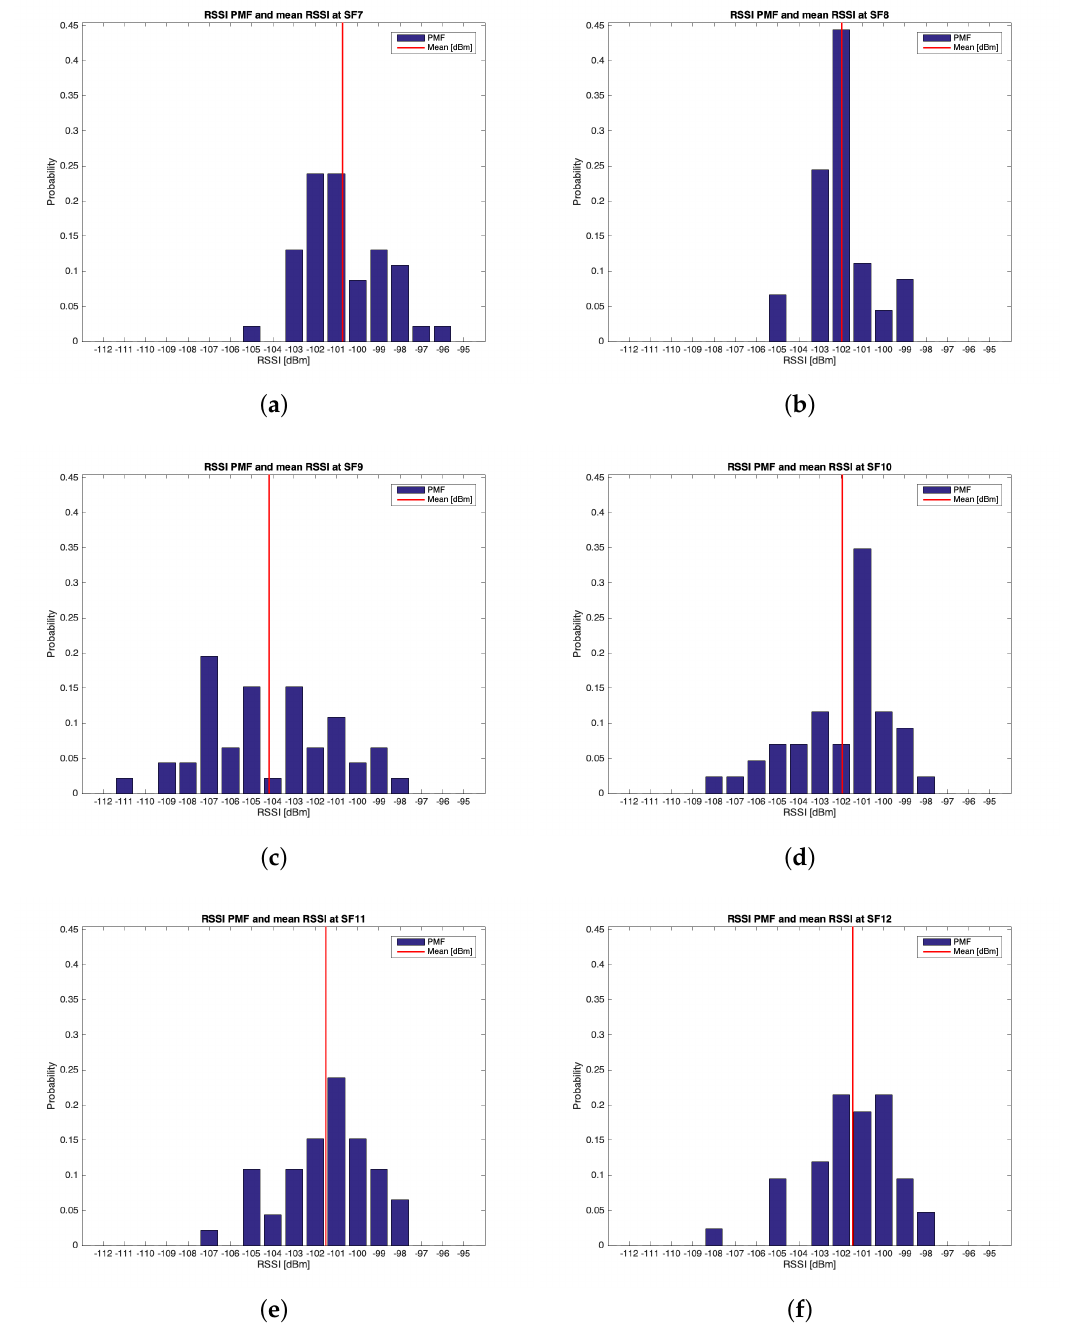
Figure 14. Group #2 RSSIs PMFs: ( a ) SF = 7; ( b ) SF = 8; ( c ) SF = 9; ( d ) SF = 10; ( e ) SF = 11; ( f ) SF =